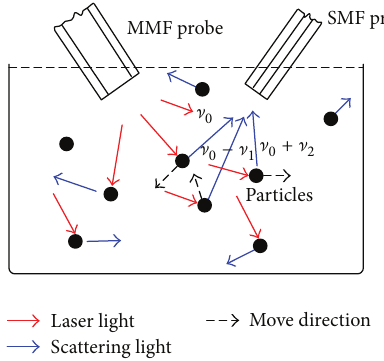
Figure 1: Schematic diagram of optical fiber dynamic light scatter- ing measurement.